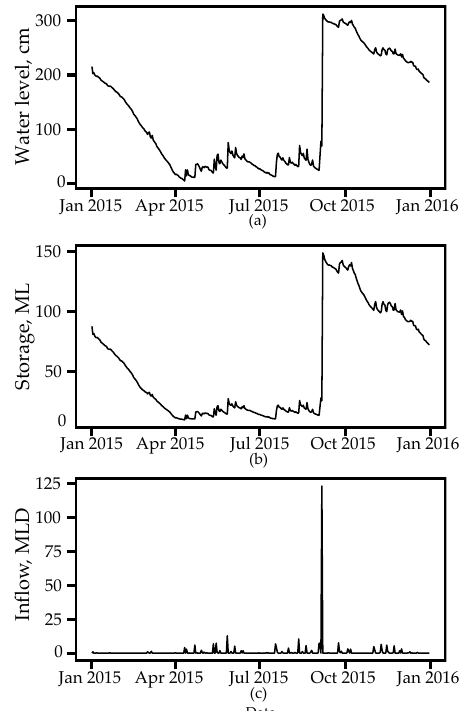
Figure 9. Water in Hadonahalli tank in 2015, including ( a ) water level; ( b ) water storage (millions of liters); and ( c ) daily inflow (millions of liters per day). Note: days without inflow (and therefore a negative change in storage due to groundwater recharge and evaporative losses) were set to zero for the daily inflow plot.